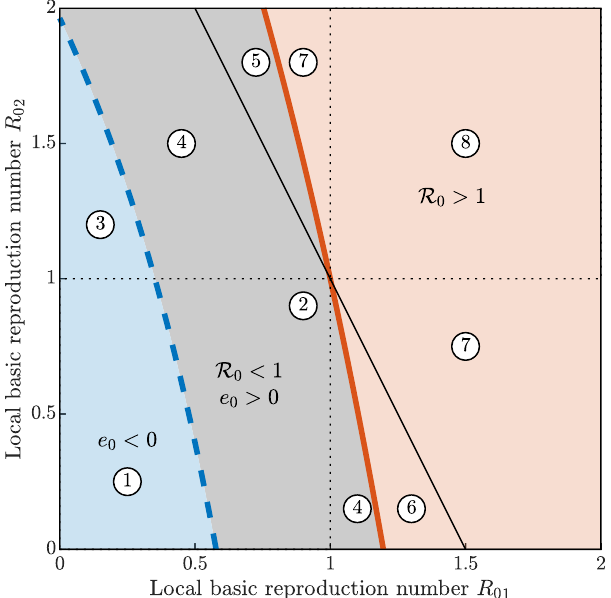
Fig. 2 The inadequacy of local reproduction numbers in spatially explicit systems. A catalog of dynamical behaviors for the two-community system of Fig. 1 (red: large outbreaks and endemic transmission are possible because R 0 > 1; gray: transient epidemic waves may be possible because R e 0 > 0, but transmission fades away eventually because 0 < 1; blue: no epidemic waves because e 0 < 0). See text for an explanation of the speci fi c dynamical outcomes in different parameter subregions ( ① to ⑧ ). Note that points ① , ② , and ⑧ correspond to the parameter combination used in Fig. 1 for (a – c), (d – f), and (g – i), respectively. The two communities are characterized by different values of the local basic reproduction number because of differences in the local values of the transmission rates. Parameters and other details as in Fig. 1.